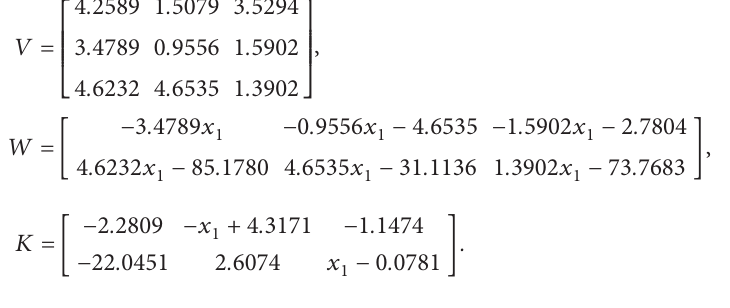
Figure 3: Comparison of x